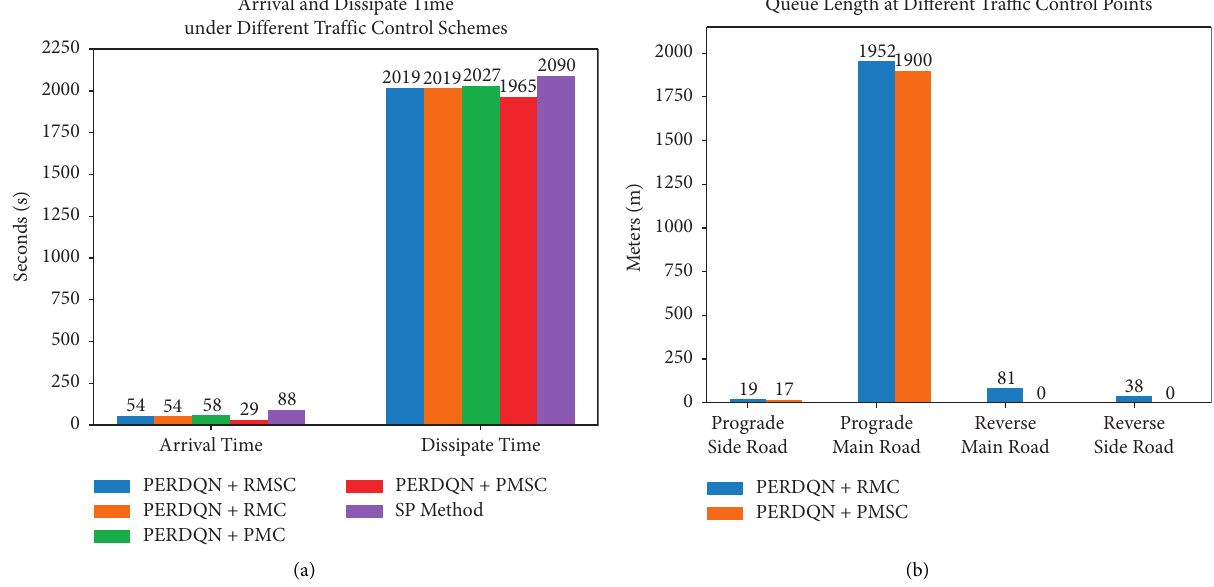
Figure 7: Evaluation parameters of different paths planned by PERDQN and SP under different traffic control schemes in case 2. (a) The arrival time and dissipation time of vehicle queue for different traffic control schemes. (b) Queue length of scheme 2 and scheme 4 at different traffic control